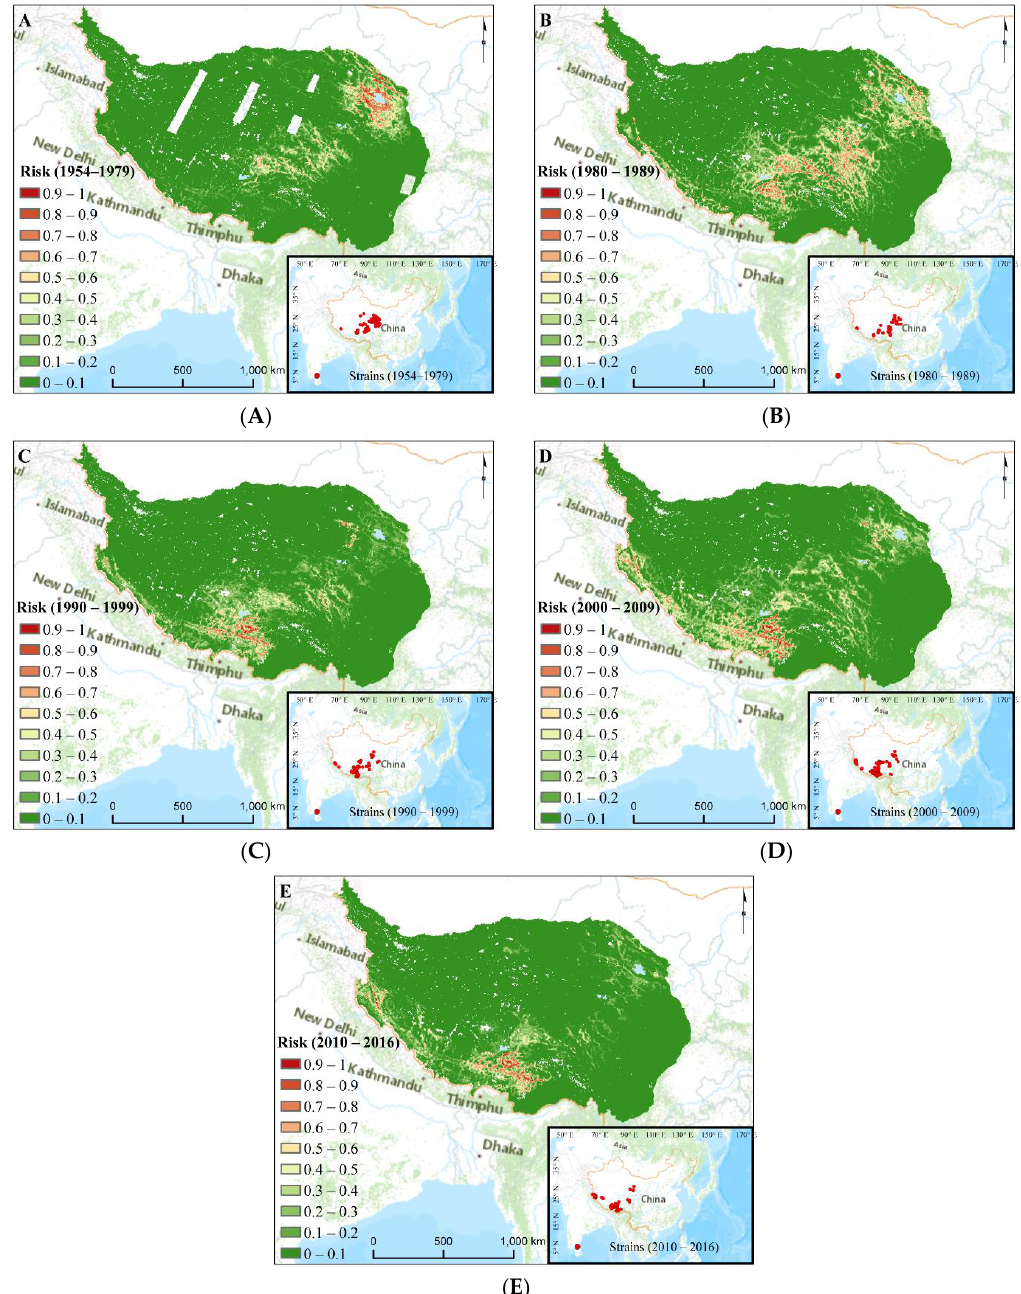
Figure 1. Distributions of plague risk at various stages. ( A ) The distributions of plague risk in 1954 – 1979 (White blocks are due to the scarcity of Landsat data with cloud cover less than 10); ( B ) The distributions of plague risk in 1980 – 1989; ( C ) The distributions of plague risk in 1990 – 1999; ( D ) The distributions of plague risk in 2000 – 2009; ( E ) The distributions of plague risk in 2010 – 2016. Further- more, most of the historical plague data shown in the bottom right corner has been anonymized by aggregation at the county level, fulfilling rules of confidentiality.